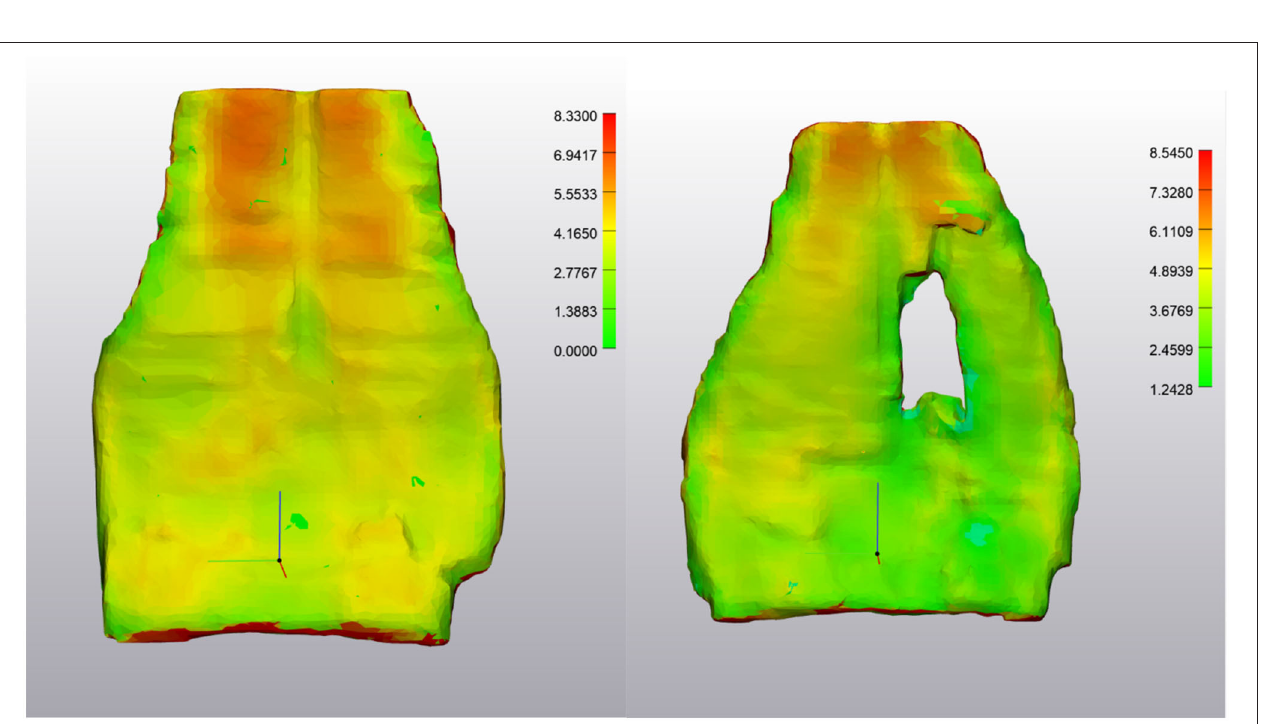
FIGURE 5 | ABNORMAL Deep Digital Flexor Tendon. (Left) Tendon thickness evaluation at first time point. Measurements are in mm. Thickness range is 1.38–8.33mm. (Right) Tendon thickness evaluation from the same horse 10 months later. Thickness range 1.24–8.54mm, however, note the large absence of data associated with the tendon lesion and thinner normal tendon tissue surrounding the lesion. This is the same tendon as Figure 4 . Top of the image represents the proximal aspect of the tendon.